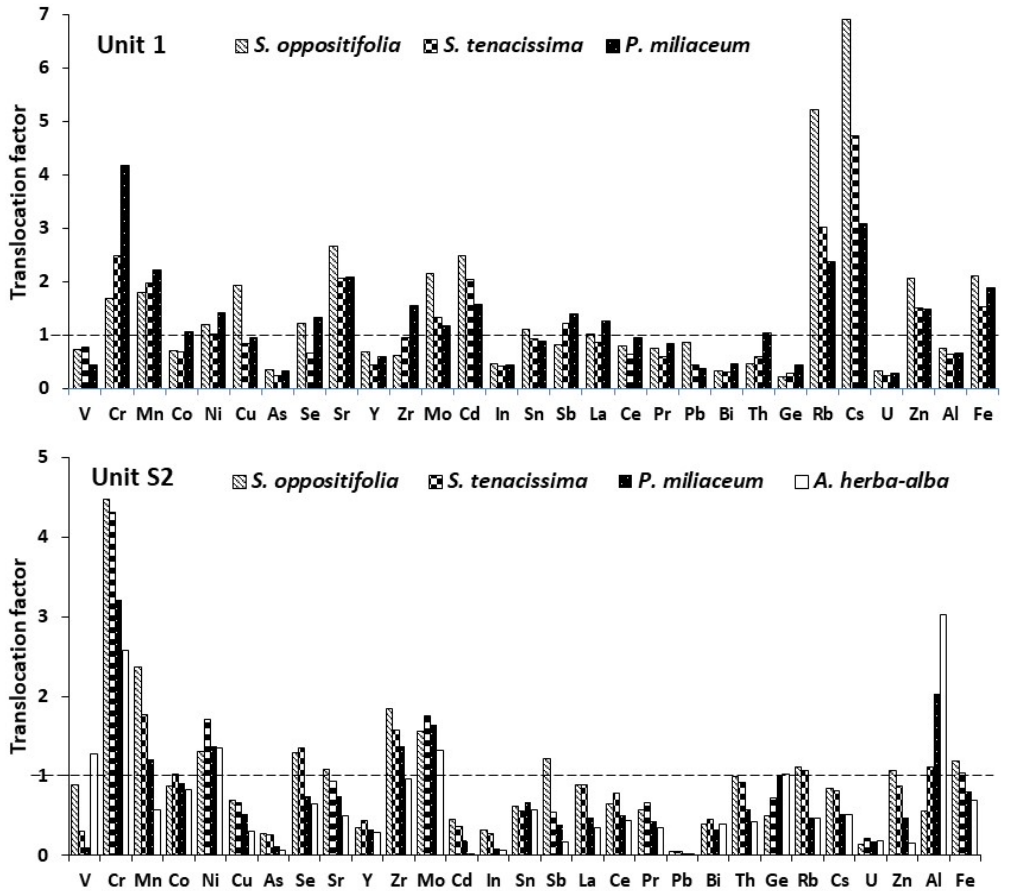
Figure 2. Translocation Factor (TF) for different metal(loid)s and REEs in Unit S1 and Unit S2. In our study, total Al concentration in plant samples ranged from 578 mg kg − 1 ( S.